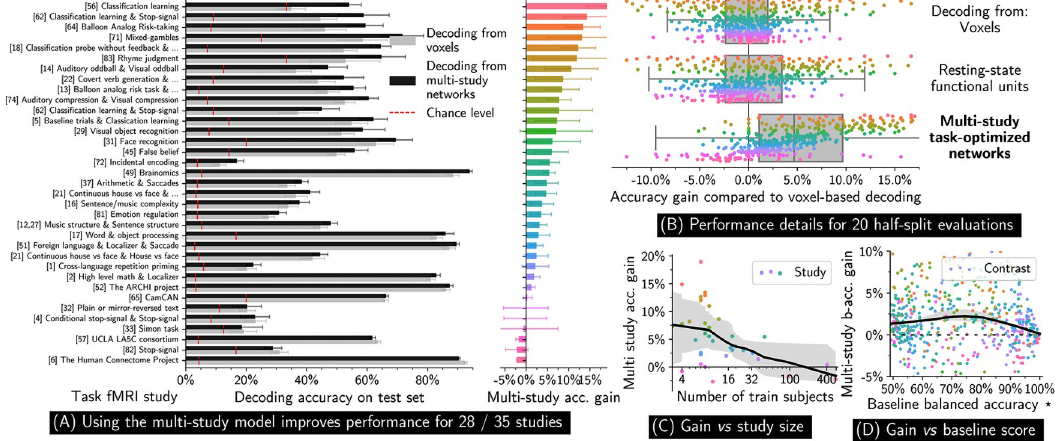
Fig 2. Quantitative performance of multi-study decoding. (A) Multi-study decoding improves the performance of cognitive task prediction across subjects for most studies. (B) Overall, decoding from task-optimized networks leads to a mean improvement accuracy of 5.8% compared to voxel or networks based approaches. Each point corresponds to a study and a train/test split. (C) Studies of typical size strongly benefit from transfer learning, whereas little information is gained for very large studies. (D) Contrasts that are moderately difficult to decode benefit most from transfer. Error bars are calculated over 20 random data half-split. � (D) shows per-contrast balanced accuracy (50% chance level), whereas per-study classification accuracy is used everywhere else. Numbers are reported in Table A in S1